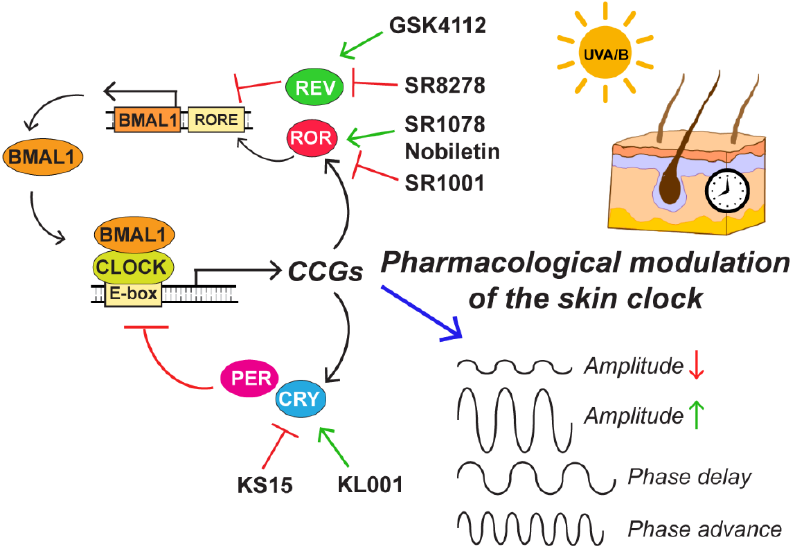
Figure 7. Pharmacological modulation of the skin circadian clock. Several small-molecule compounds that target circadian clock proteins have been discovered in the past few years. The application of these compounds onto human skin could potentially be used to transiently alter the amplitude or phase of CCG expression to prevent or treat skin diseases.